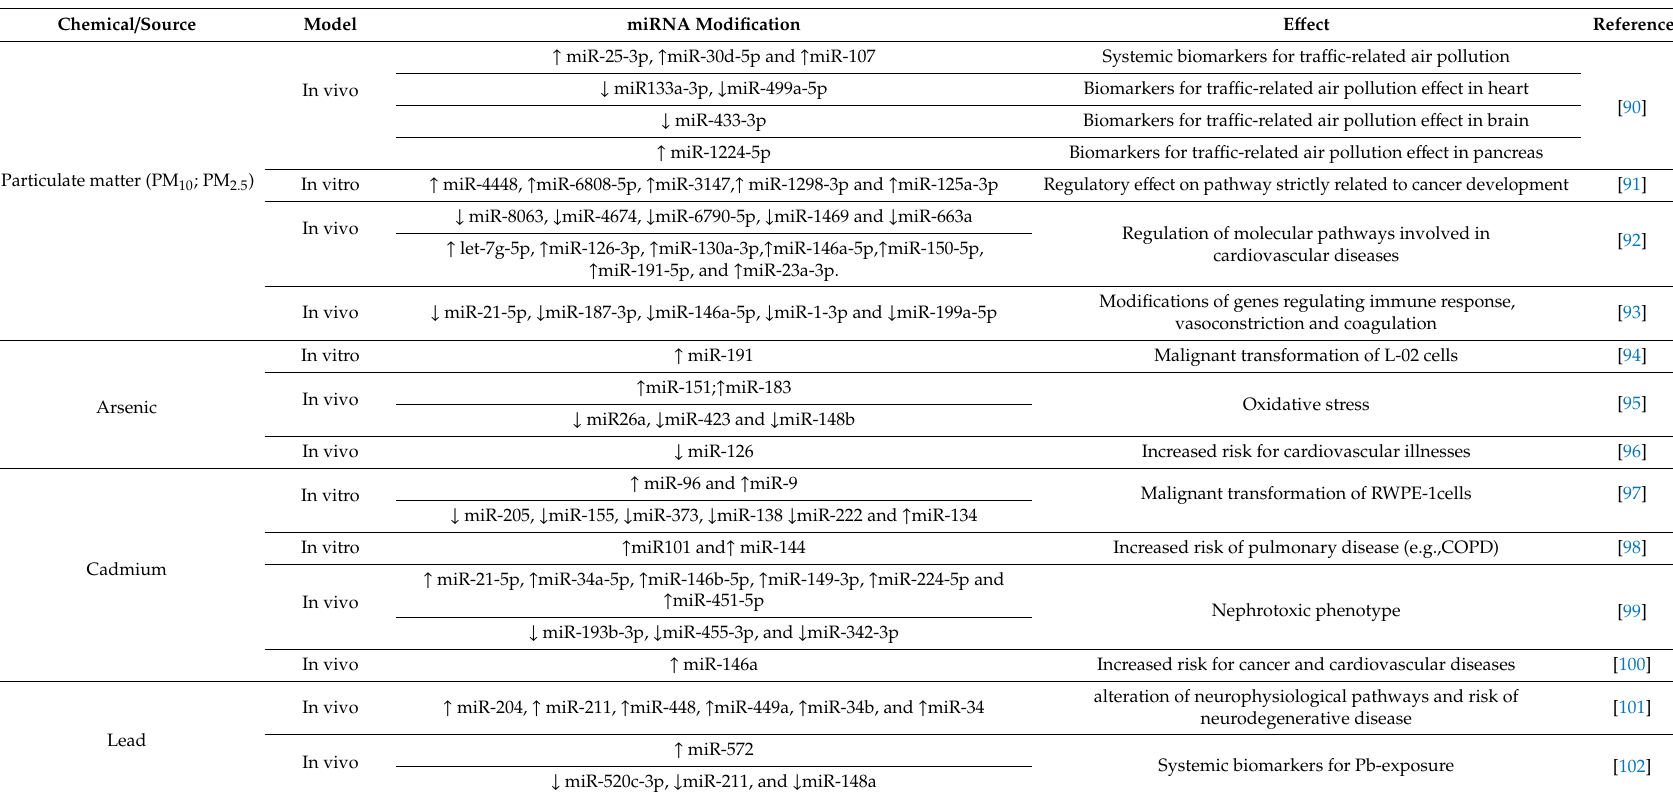
Table 1. The e ff ect of pollutant exposure on miRNA expression profiles and its